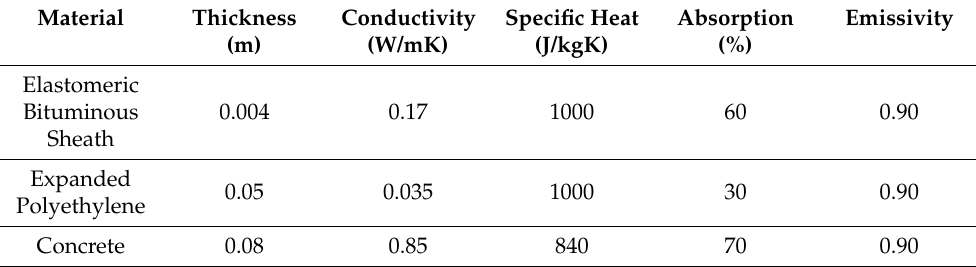
Table 6. Stratigraphy settings for the building roofs, using a waterproofing membrane.